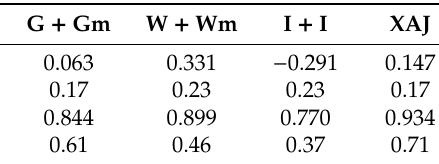
Table 9. The mean values of four metrics shown in Figure